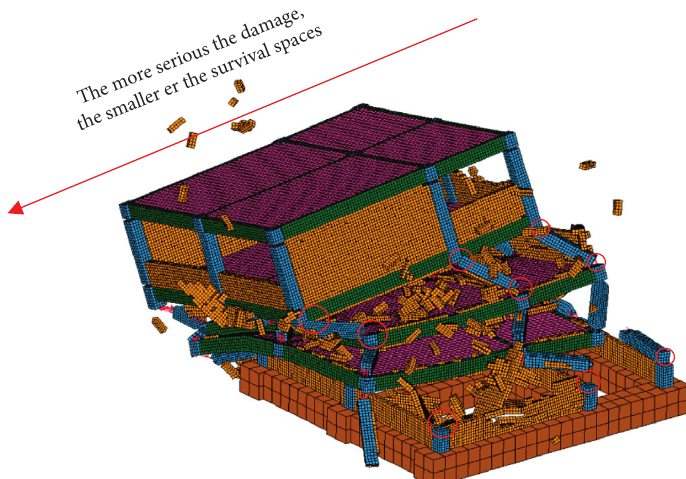
Figure 55: The distribution of horizontal survival spaces.